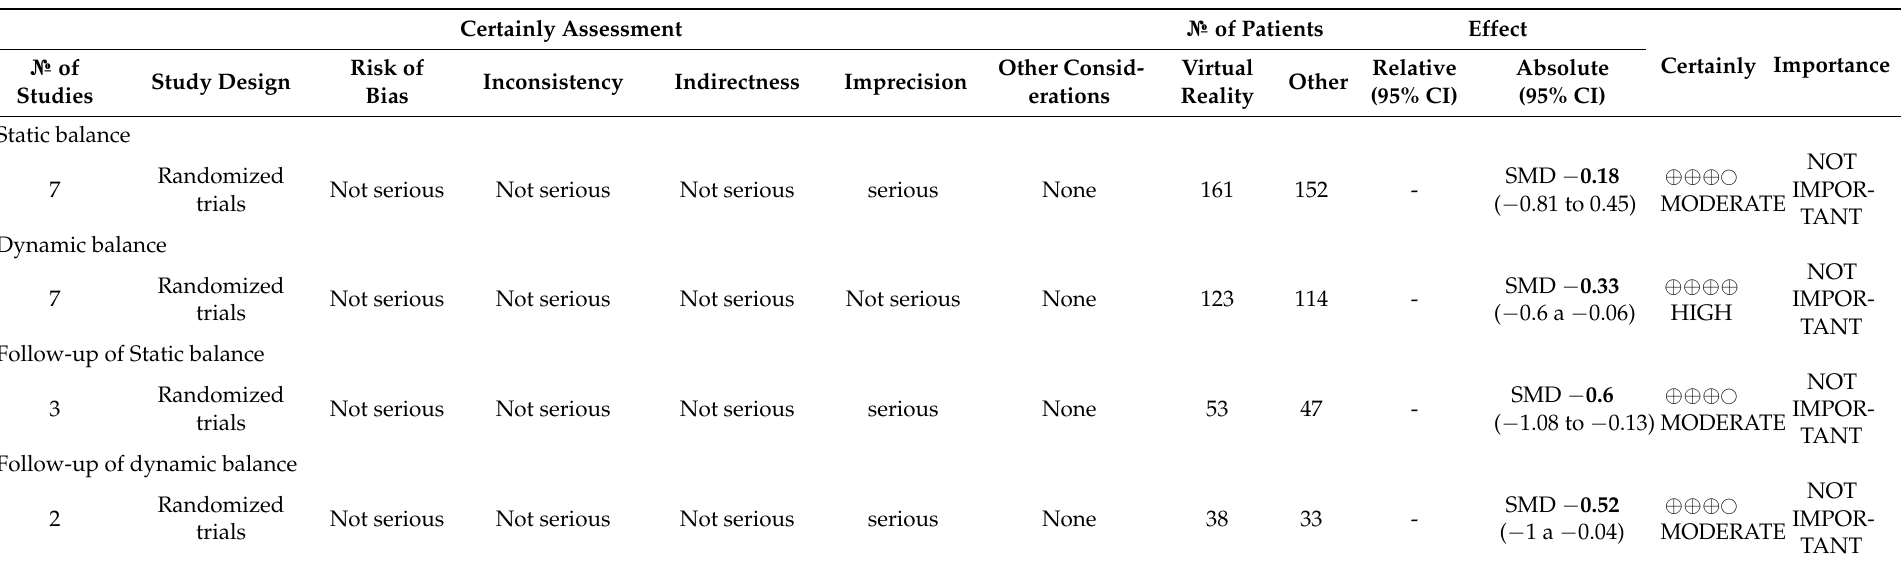
Table 5. Recommendations according to GRADE